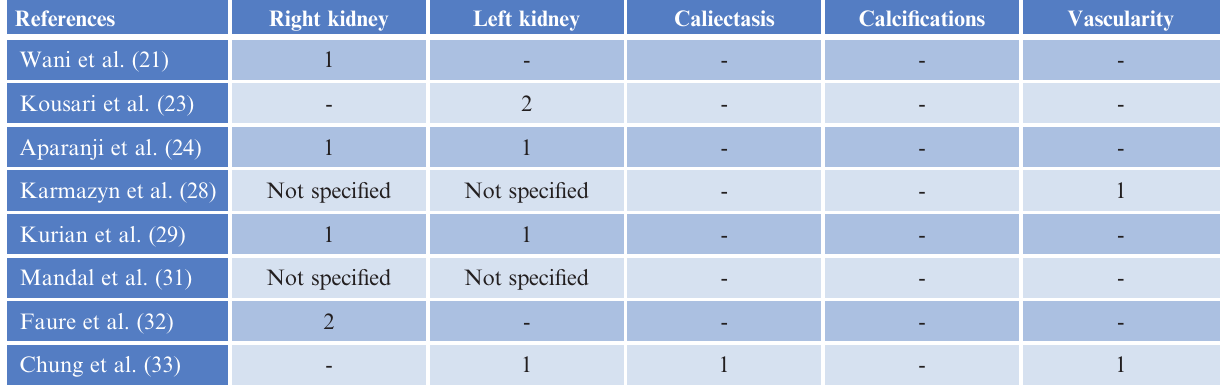
Table 1. US features of pediatric